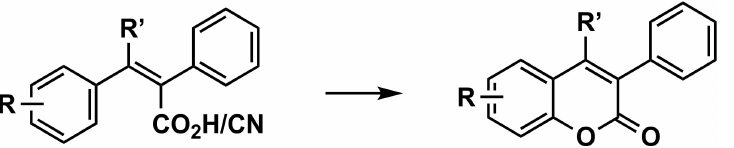
Figure 7. One of the synthetic routes to obtain 3-phenylcoumarins: construction of the coumarin from cinnamic